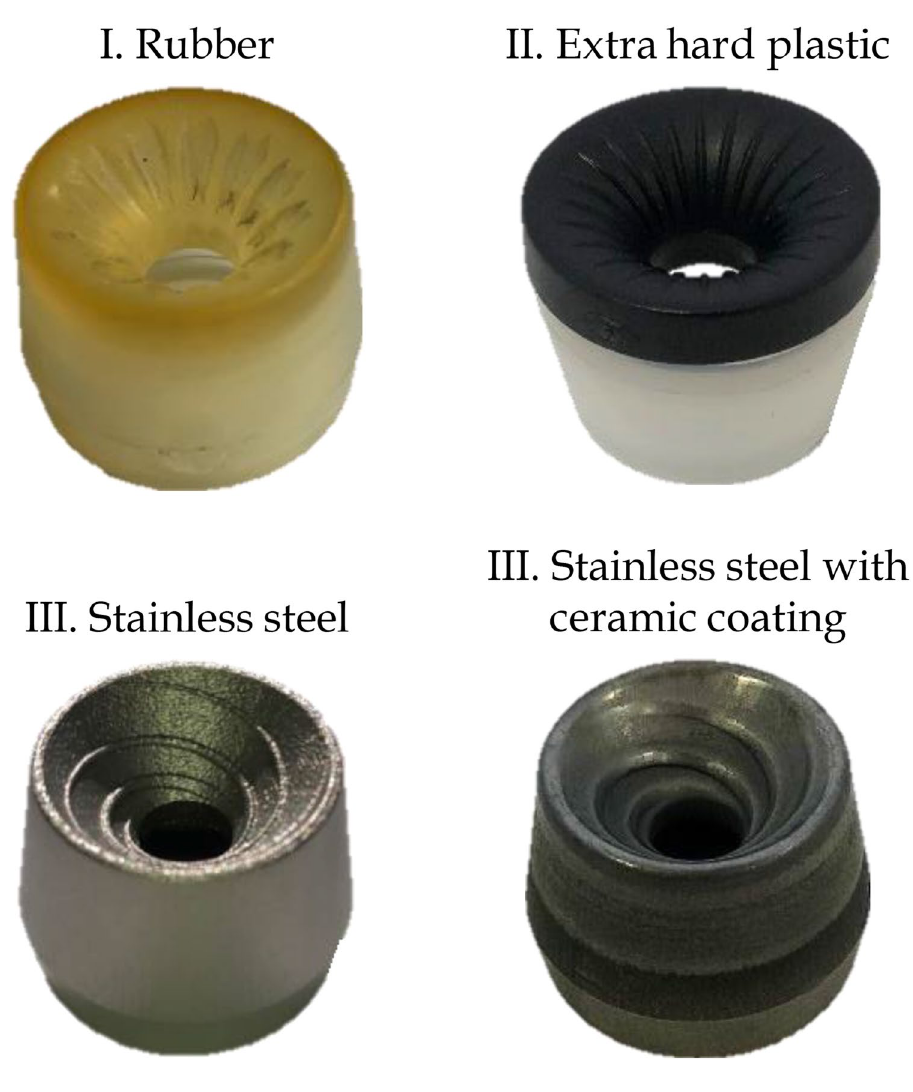
Fig. 5 False twisters for the spinning of metal spun yarns with flyer spinning technology